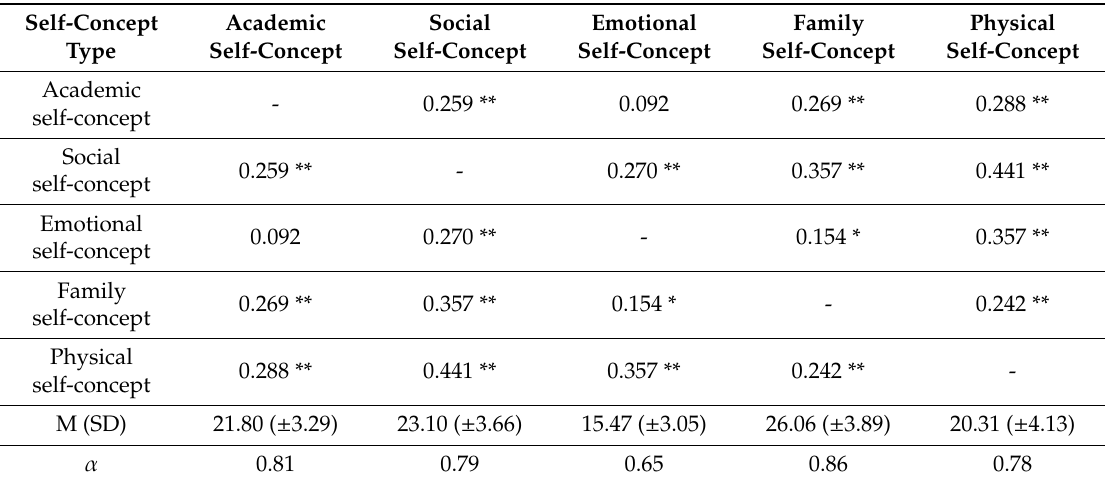
Table 1. Spearman’s bivariate correlations and descriptive statistics of the self-concept.